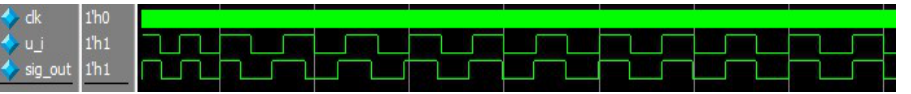
Figure 10. Input signal frequency